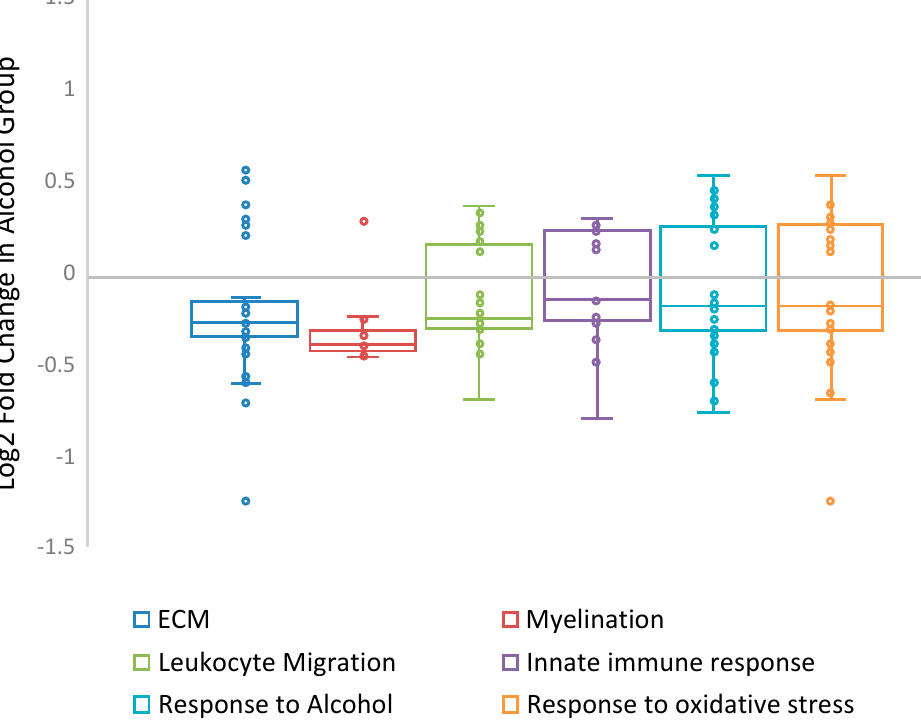
Figure 3. General directionality of CIE-induced gene expression changes within major CNS cell types ( A ) and selected over-represented functional groups ( B ). Individual DEGs are represented by small circles. Median expression of DEGs for each biological category is shown as a horizontal line within the 50% interquartile range. OPC: oligodendrocyte progenitor cells; MO: myelinating oligodendrocytes; ECM extracellular matrix.